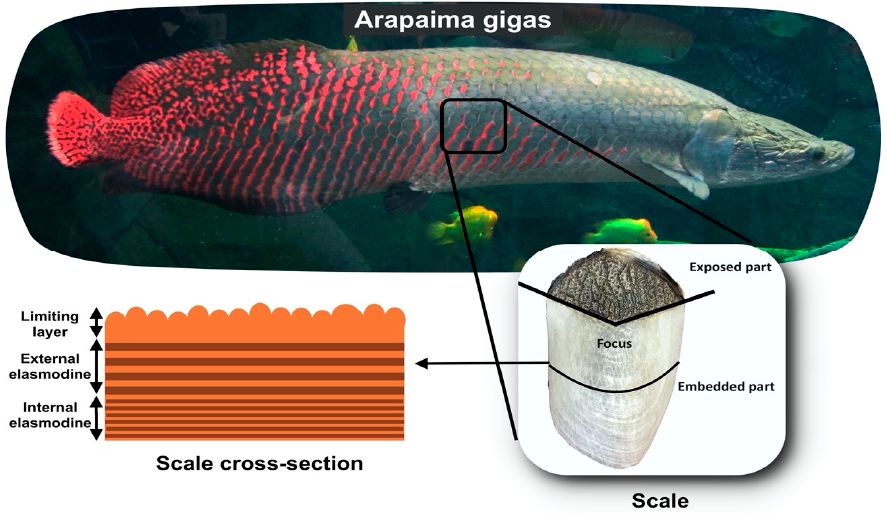
Figure 1. The Arapaima gigas , its scale, and a schematic representation of the hierarchical structure of the scales.